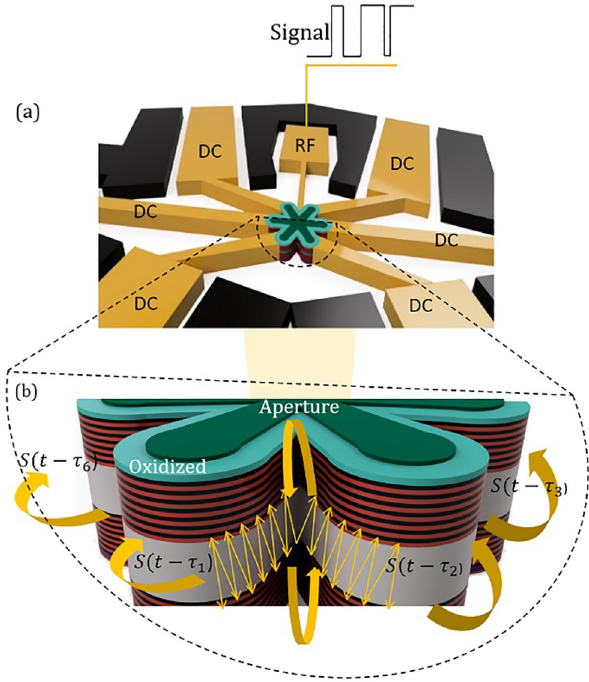
Figure 1: Schematic structure of our hexagonal transverse-coupled- cavity vertical-cavity surface-emitting lasers (VCSEL) (a) Top view, and (b) Cross-sectional view. The six outer cavities are designed to have the same resonant wavelength ω at I feedback < I th . I laser = mI th . When I laser increases resonant wavelength red shift like its con- ventional